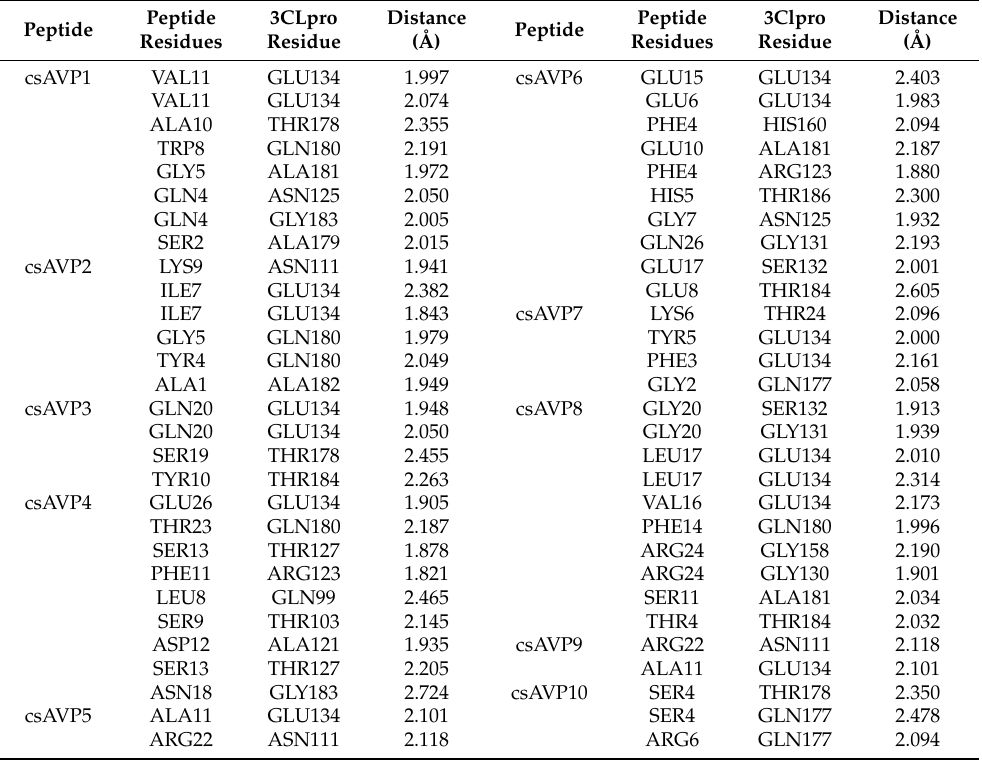
Table 5. List of hydrogen bonds observed from molecular docking of ten peptides (csAVP1 to